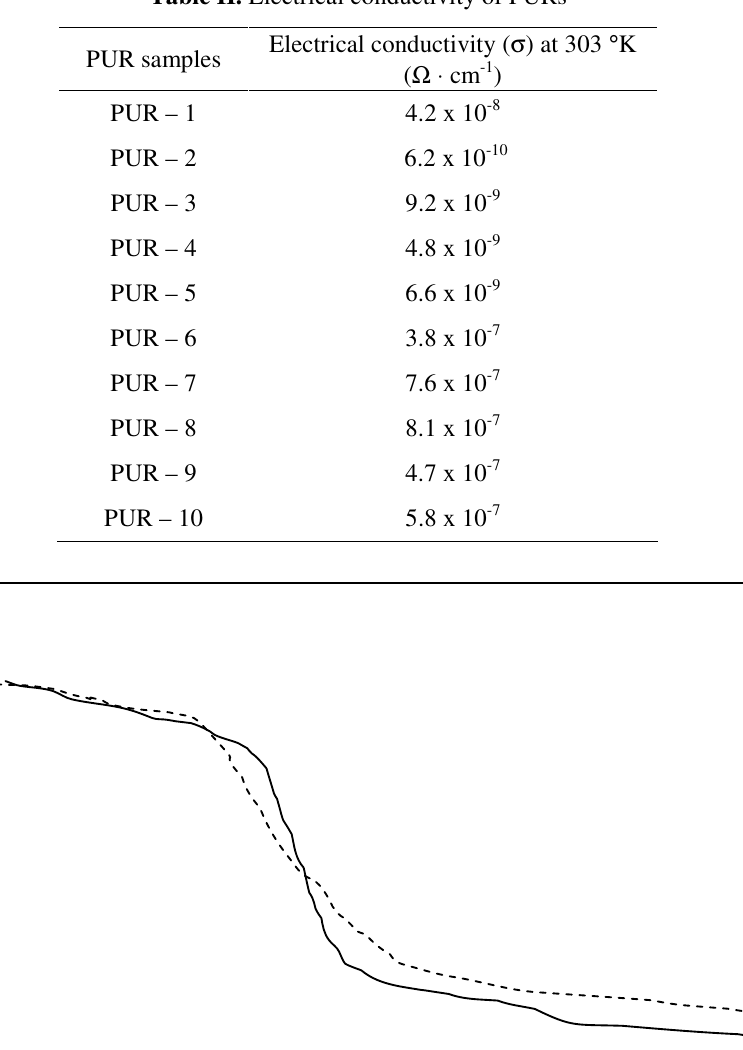
Table II. Electrical conductivity of PURs